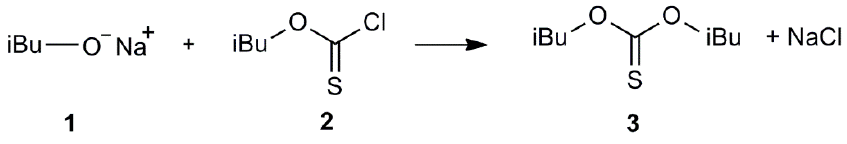
Table 2. Results of N ‐ alkyl ‐ , N , N ‐ dialkyl ‐ , and N ‐ cycloalkyl ‐ O ‐ isobutyl thiocarbamate synthesis.